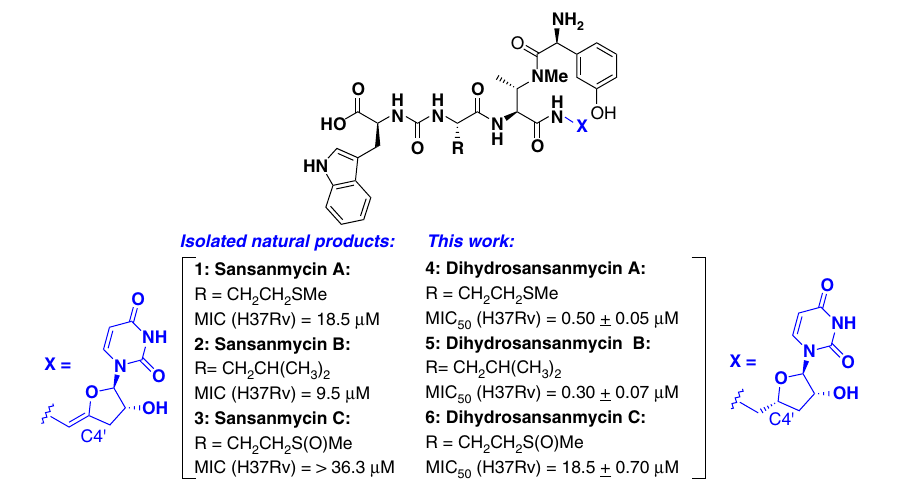
Figure 1 | Structures of sansanmycins A-C (1–3), synthetic dihydrosansanmycins A–C (4–6) and inhibitory activity against Mtb H37Rv. MIC values of isolated sansanmycins A–C ( 1–3 ) were previously reported by Xie et al. 14,15 MIC 50 values of 4–6 represent the average of two independent experiments, each performed in triplicate; positive controls RIF: MIC 50 ¼ 0.006 ± 0.002 m M; INH: MIC 50 ¼ 0.025 ± 0.005 m M; MIC 50 (HEK293) for 4–6 4 200